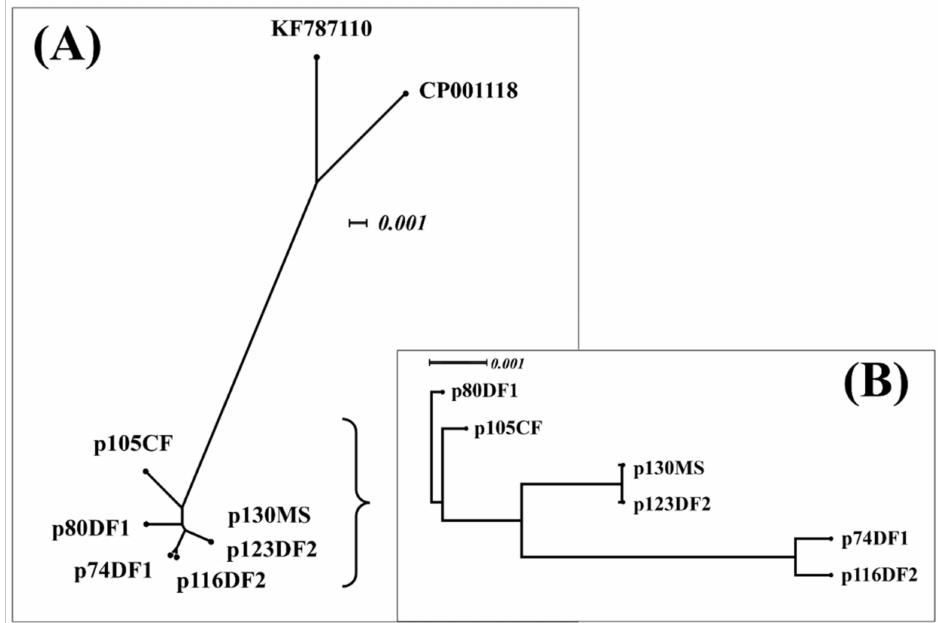
Figure 5. Relatedness of the genomes of the six plasmids in this study. ( A ) An unweighted pair group method with arithmetic mean (UPGMA) phylogram of the six CTX-M-14 plasmids and highly similar plasmid sequences was created using the SplitsTree4 program using uncorrected P characters, UPGMA distances, and equal angle spilt transformations. ( B ) UPGMA phylogram of the six CTX-M-14 plasmids and a highly similar plasmid was created using the SplitsTree4 program using uncorrected P characters, UPGMA distances, and rooted equal angle